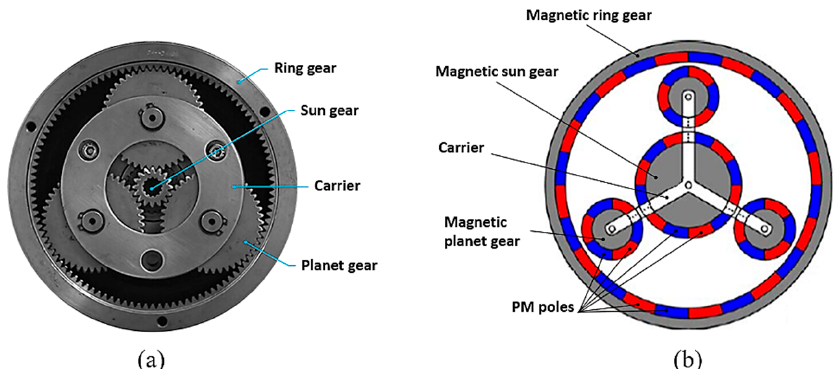
Figure 5. Planetary gear: ( a ) Mechanical; ( b ) Magnetic.